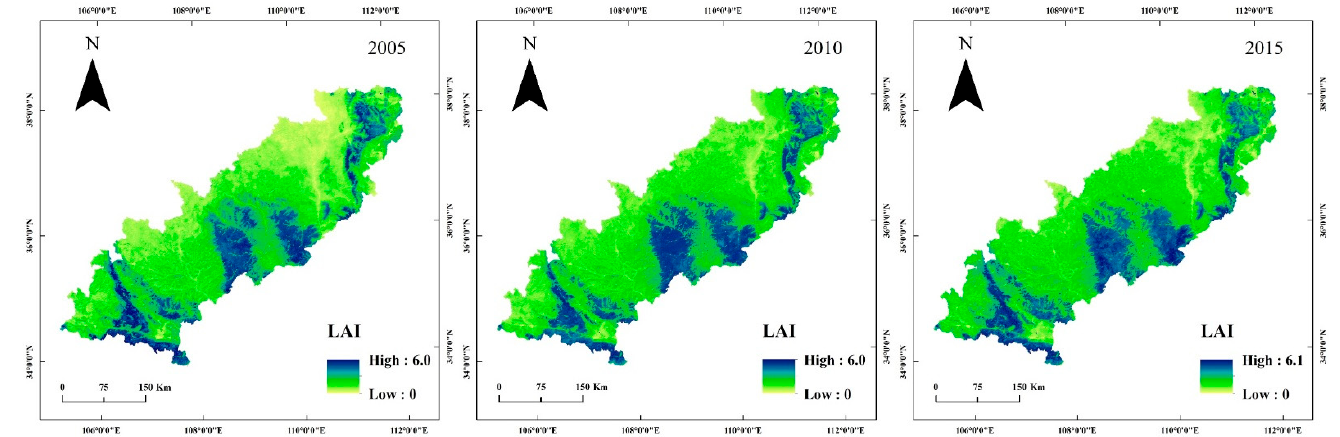
Figure 11. Distribution of LAI in the Loess Plateau Ecological Screen from 2005 to 2015.